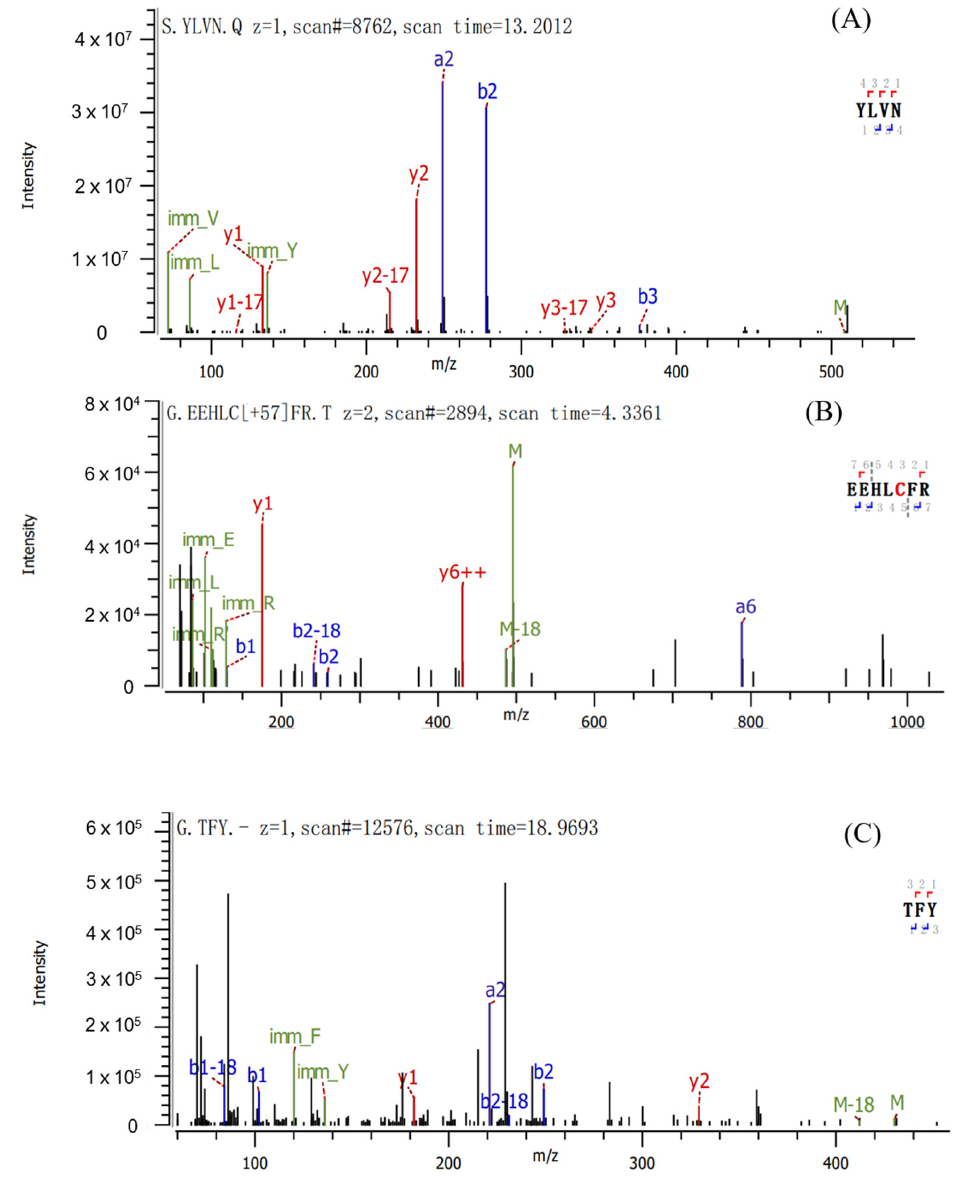
7 of 20 Figure 5. Elution profile of fraction loaded on Xselect TM CSH130 (Ø4.6 × 250 mm, 3.5 μ m). Elution profile of fraction П -2-6-3 ( A ); elution profile of fraction П -2-6-5 ( B ); elution profile of fraction П -2- 6-7 ( C ). 2.2. Sequence Identification and Antioxidant Activities of Three Antioxidant Peptides The sequence of peptides was identified based on LC-MS/MS, and the results are shown in Figure 6A–C and molecular mass and amino acid sequence of three peptides are shown in Table 1. The mass spectrum of Figure 6A illustrated the FII-2-6-3 was identified as Tyr-Leu-Val-Asn (YLVN, named Peptide 1) with MW of 507.59 Da, correspondingly Figure 6B illustrated FII-2-6-5 was Glu-Glu-His-Leu-Cys-Phe-Arg (EEHLCFR, named Peptide 2) with MW of 933.06 Da, and Figure 6C illustrated FII-2-6-7 was Thr-Phe-Tyr